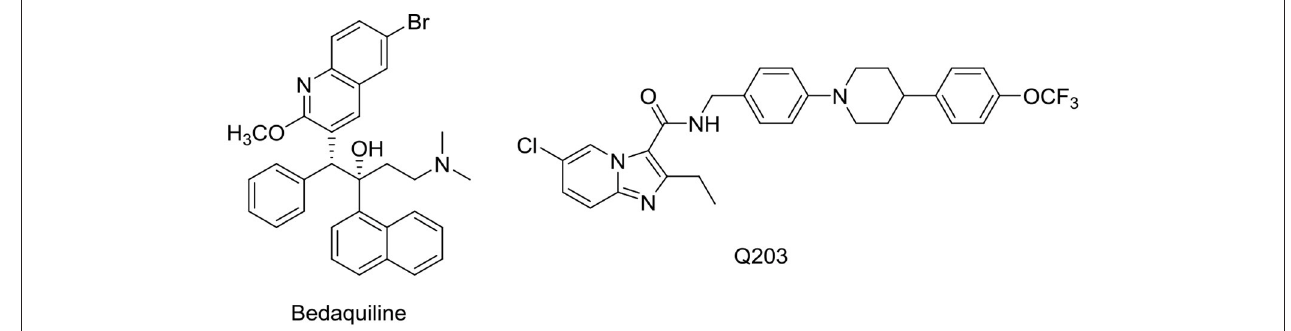
FIGURE 1 | Structures of bedaquiline and Q203. Log P of bedaquiline and Q203 were estimated to be 7.71 and 6.71 respectively. In comparison, the log P of isoniazid, pyrazinamide and ethambutol (standard anti-TB drugs) are − 0.64, − 1.31, and 0.06 respectively. Log P -values were obtained from ChemDraw Professional, Version 15.